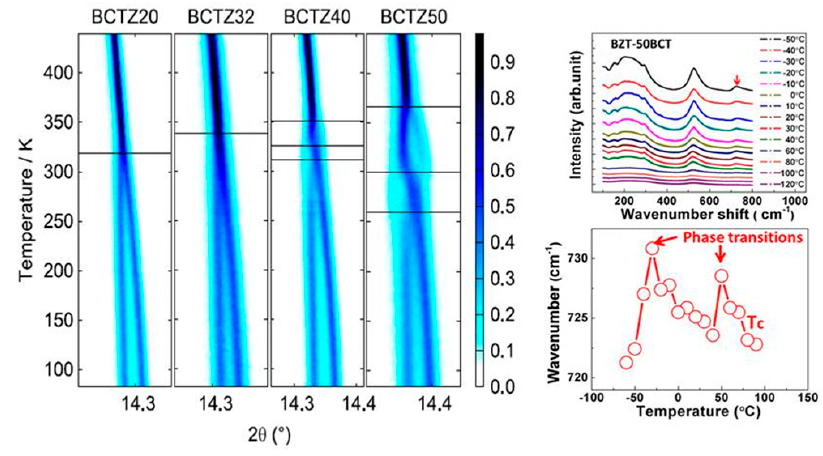
Figure 10. The high-resolution X-ray diffraction (XRD) ( left ) and Raman spectrum for BZT–BCT piezoceramics ( right ) [71,72].